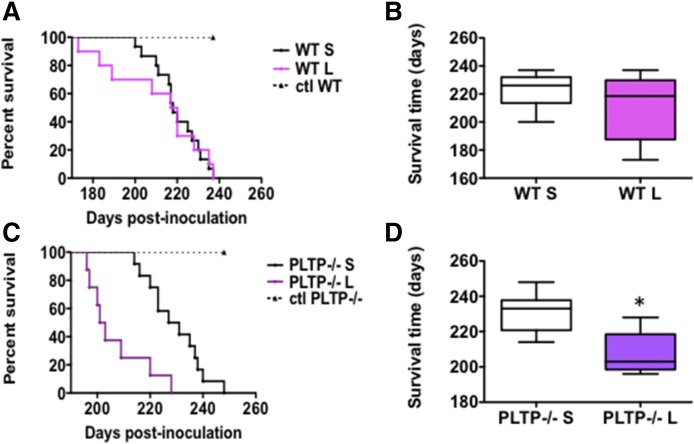
Western-type cholesterol-rich diet markedly accelerates prion disease in PLTP−/− mice. A: Kaplan-Meier survival plots of WT mice inoculated with 150 μl of 22L prion strain by the ip route and fed with either a standard chow diet (WT S; in black, n = 15) or a Western-type cholesterol-rich diet (WT L; in pink, n = 10). In each group (WT S and WT L), five mice were inoculated with 150 μl of PBS by the ip route to serve as controls. B: Box-and-whiskers representation of median survival time of Kaplan-Meier plots presented in (A). The median survival time, 226 dpi for WT S mice versus 218 dpi for WT L mice, is not statistically different [Log-rank (Mantel-Cox) test]. C: Kaplan-Meier survival plots of PLTP−/− mice inoculated with 150 μl of 22L prion strain by the ip route and fed with either a standard chow diet (PLTP−/− S; in black, n = 13) or a Western-type cholesterol-rich diet (PLTP−/− L; in purple, n = 10). In each group (PLTP−/− S and PLTP−/− L), five mice were inoculated with 150 μl of PBS by the ip route to serve as controls. D: Box-and-whiskers representation of median survival time of Kaplan-Meier plots presented in (C). The median survival time, 233 dpi for PLTP−/− S mice versus 203 dpi for PLTP−/− L mice, is statistically significant (*P < 0.05, Mantel-Cox test).